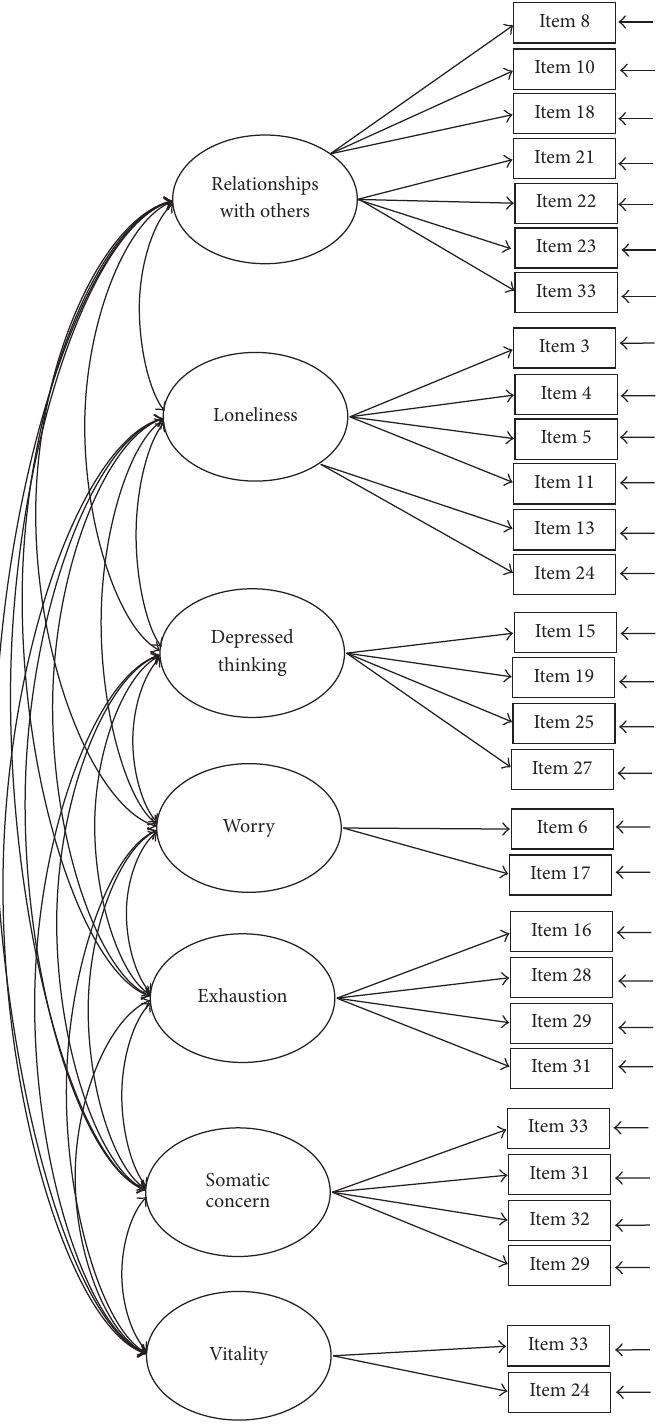
Figure 4: Model 4: the seven-correlated-factor model with 29 items. Item descriptions are in Table